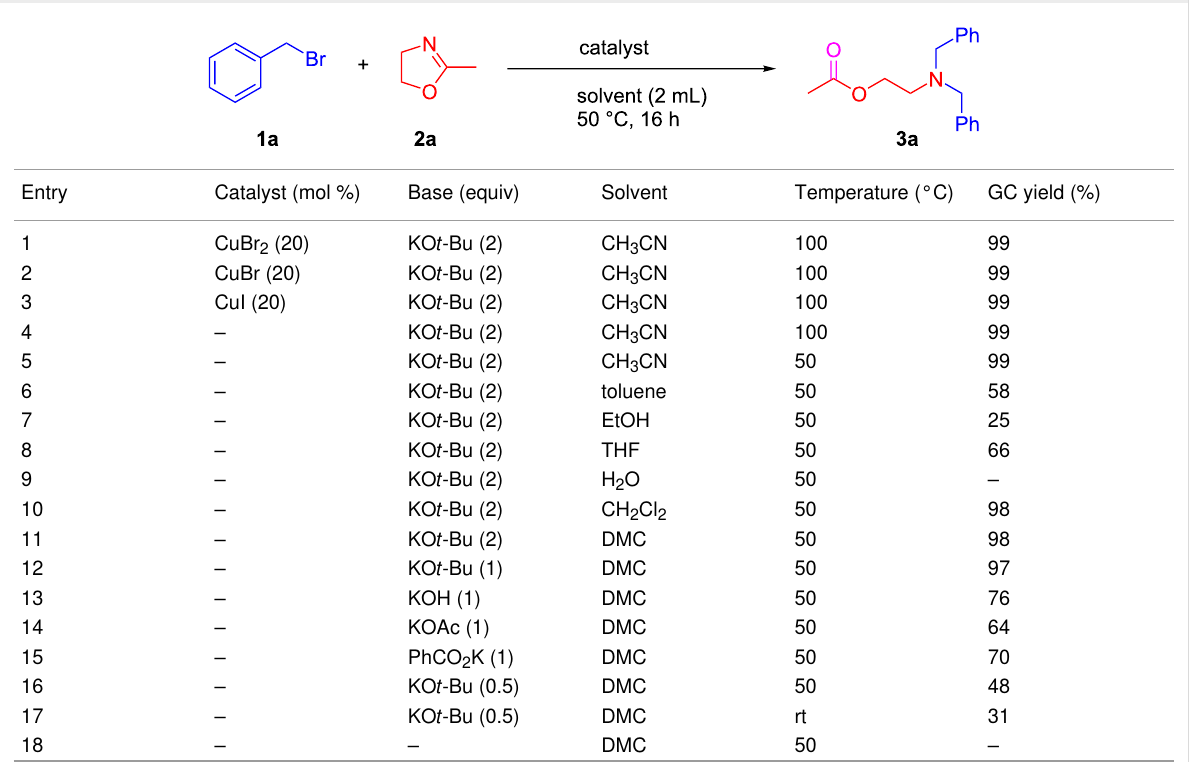
Table 1: Optimization of the KO t -Bu-promoted selective ring-opening N -alkylation of 2-methyl-2-oxazoline with benzyl bromide. a